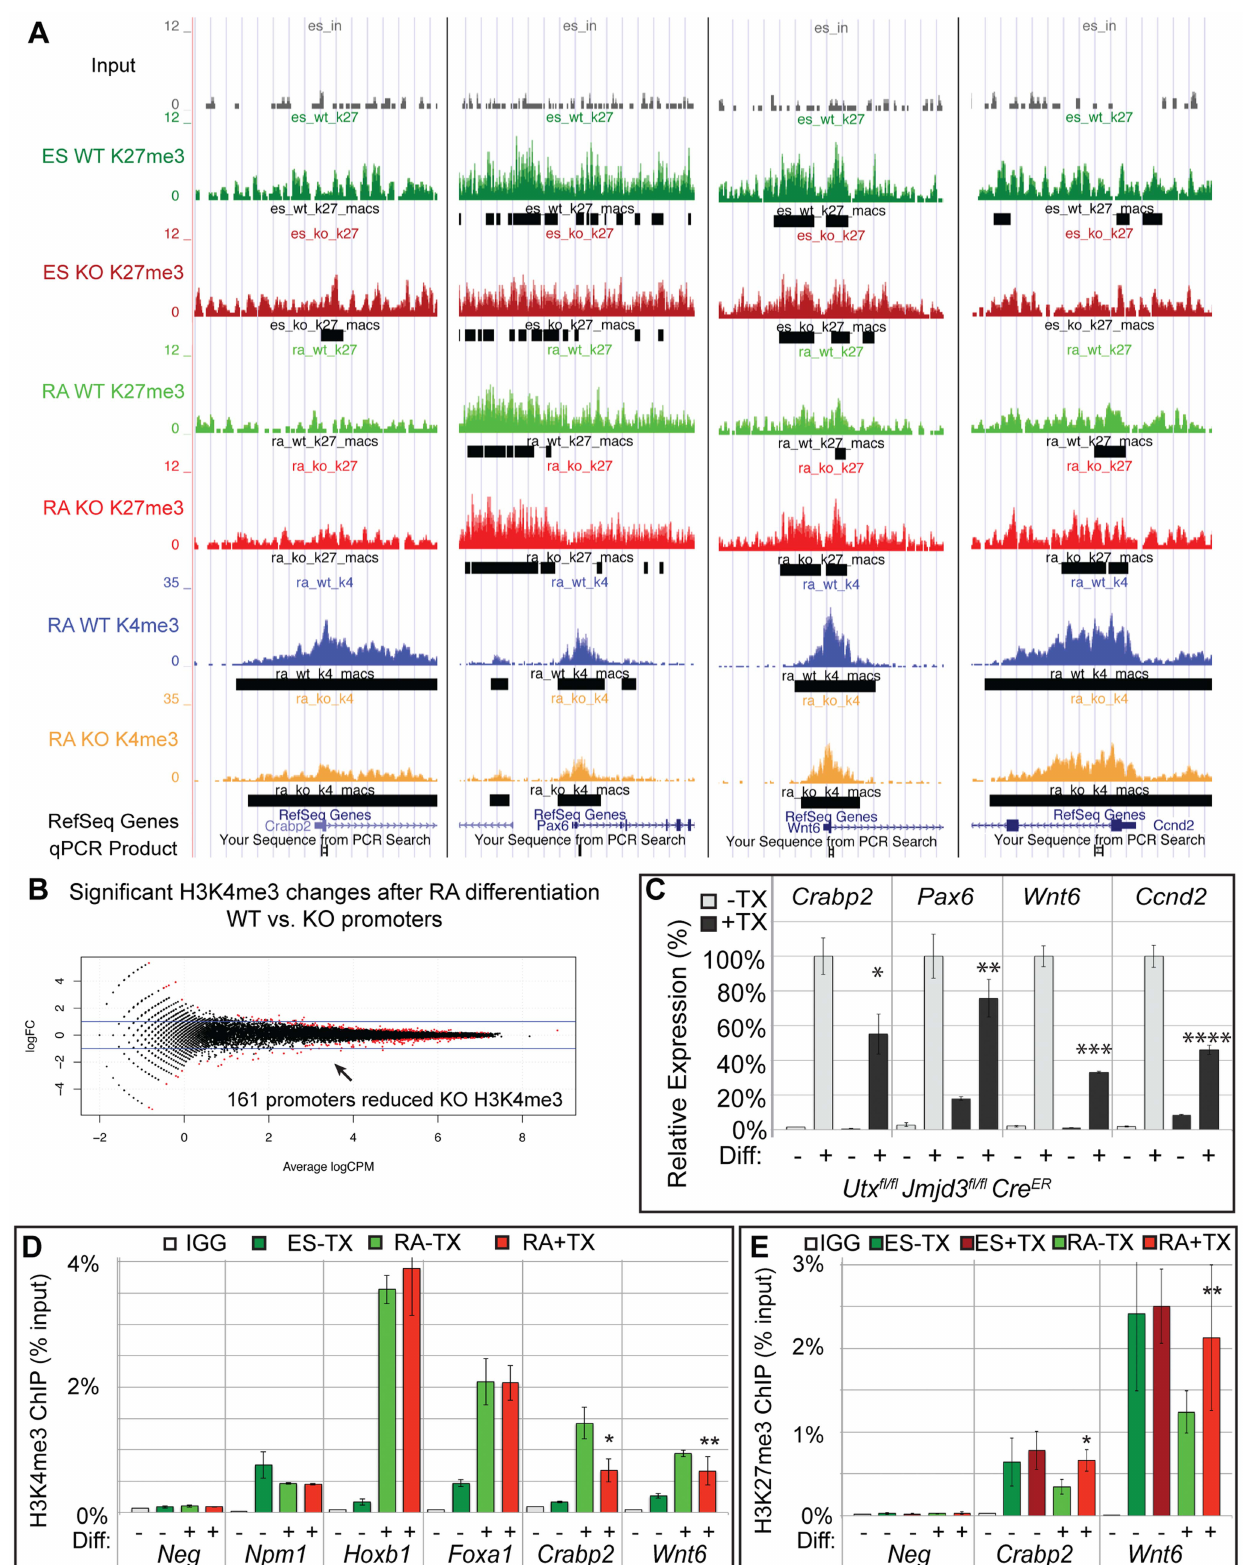
Figure 5. A subset of genes exhibit reduction of H3K4me3 with loss of UTX and JMJD3. (A) UCSC genome browser view of Crabp2 , Pax6 , Wnt6 , and Ccnd2 . Illustrated are Input (black), WT ES H3K27me3 ChIP (dark green), KO ES H3K27me3 ChIP (dark red), WT RA H3K27me3 ChIP (light green), KO RA H3K27me3 ChIP (light red), WT RA H3K4me3 ChIP (blue), KO RA H3K4me3 ChIP (orange), and MACS defined enrichment peaks are illustrated as black bars underneath each track. Regions tested by ChIP-qPCR are noted on the bottom. (B) H3K4me3 ChIP-seq was performed on